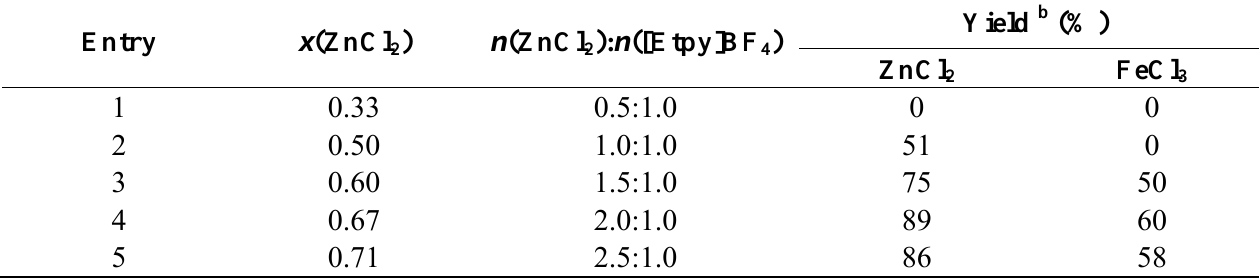
Table 2. Effect of molar fraction of Lewis acid in ionic liquid on the Friedel–Crafts reaction a